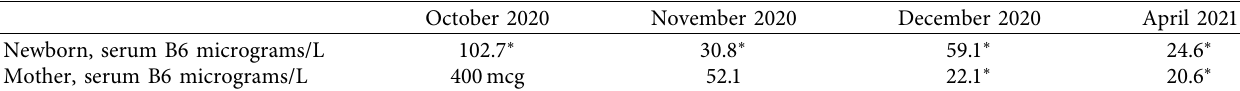
Table 2: Vitamin B6 serum levels found in patient and mother. ∗ serum normal levels (n.v. 8.7–27.2